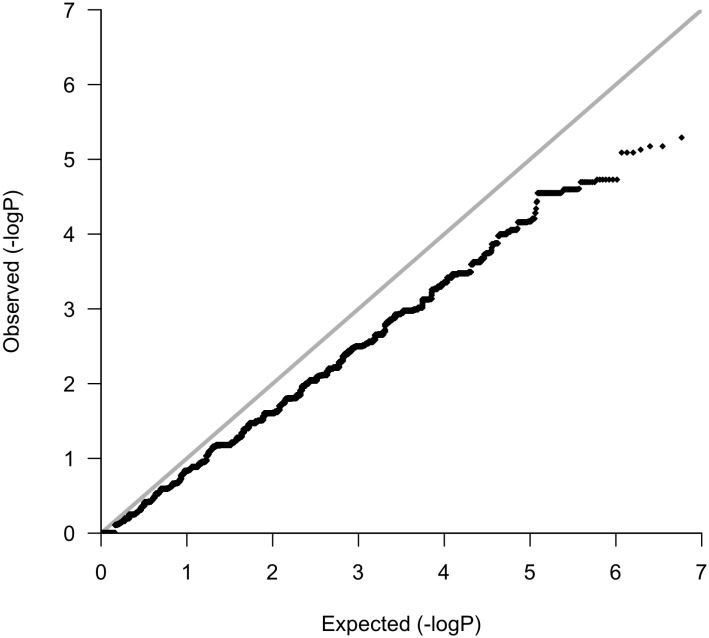
Quantile–quantile plot.